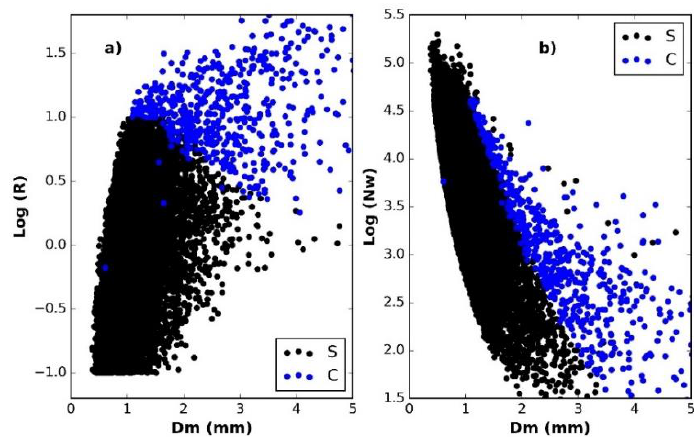
Figure 7. Distribution of the integrals variables of the RSD, this result evidence that Convective and stratiform rainfall are different. ( a ) Relationship between Log(R) and Dm, ( b ) Log(Nw) and Dm.